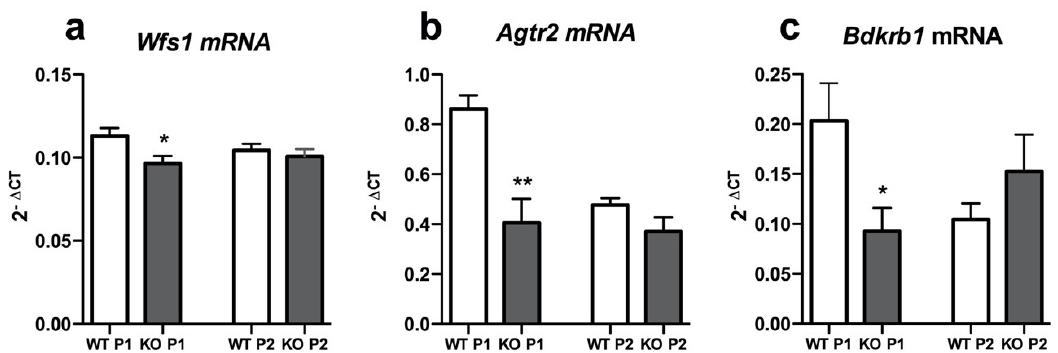
Figure 3. The expression of Agtr2 and Bdkrb1 is downregulated in in vitro primary cortical neurons from Wfs1 KO rats. Rat primary cortical neurons were prepared using the brains of wild-type control or Wfs1 KO rats and cells were cultured 24 h (P1) or 48 h (P2) post-culturing. Gene expression analysis was performed to measure the relative expression level of ( a ) Wfs1 mRNA, ( b ) Agtr2 mRNA and ( c ) Bdkrb1 mRNA. Gene expression level is presented as 2 − ∆ CT relative to the housekeeper Hprt . Data were compared using unpaired t test; * p < 0.05, ** p < 0.01 compared to respective WT group. The data are presented as the mean ± SEM, n = 6–7 per group.